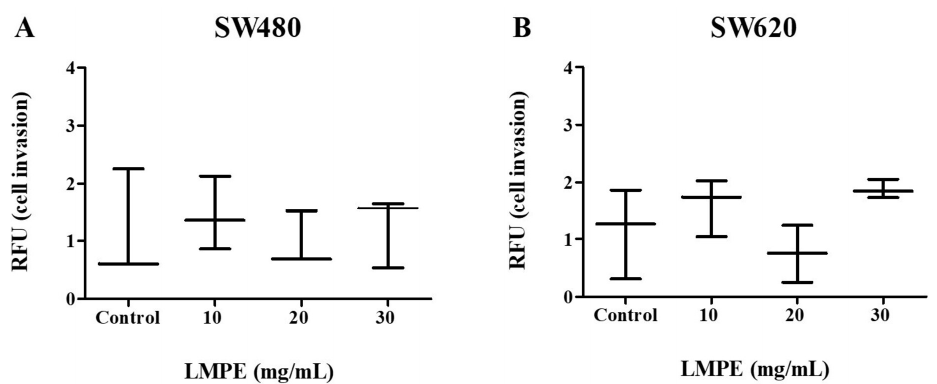
Figure 10. Effect of LMPE on invasion through an extracellular matrix in SW480 ( A ) and SW620 ( B ) cells. Cells were exposed to different treatment concentrations (10, 20, and 30 mg LMPE/mL) for 18 h. Untreated cells (0 mg LMPE/mL) were used as a control. Data were expressed as median (interquartile range) ( n = 3). The Kruskal-Wallis test was performed to compare the groups p = 0.8569 (SW480) and p = 0.1230